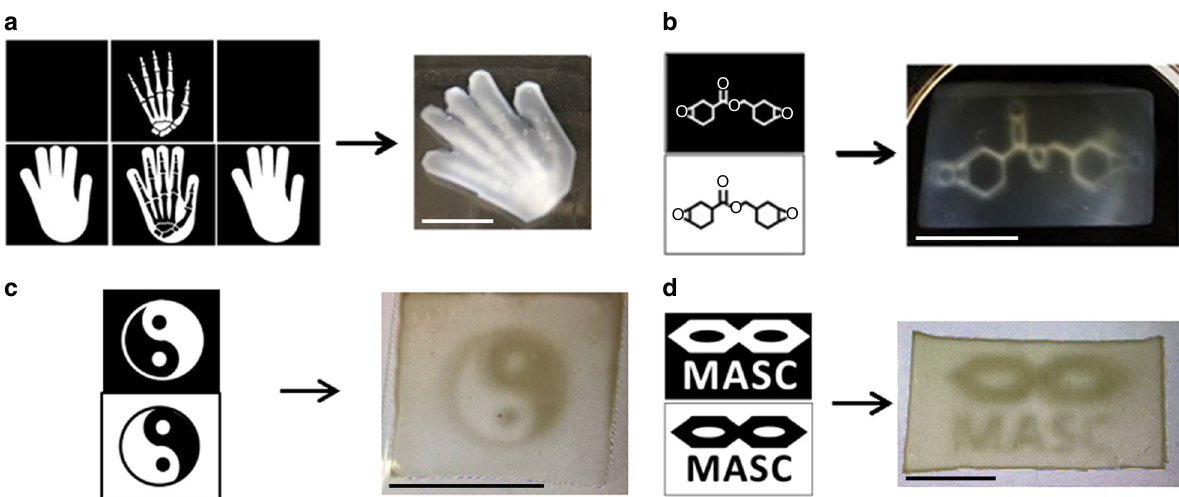
Fig. 1 Representative sets of DLP projections (arbitrary scaling) for UV (top images) and visible light (bottom images), and their corresponding printed specimens. All samples were printed using the BA-1 MASC formulation. Scale bars correspond to 25 mm. a A 3D design resembling a hand with encased internal bones. Picture taken after being removed from toluene. b An EPOX molecular structure signifying the opaque region containing the EPOX-based material. Picture taken on a black background in toluene. c A yin yang design. Picture taken with backlighting in toluene. d An in-house logo for our MASC printing process. Picture taken with backlighting in spearmint